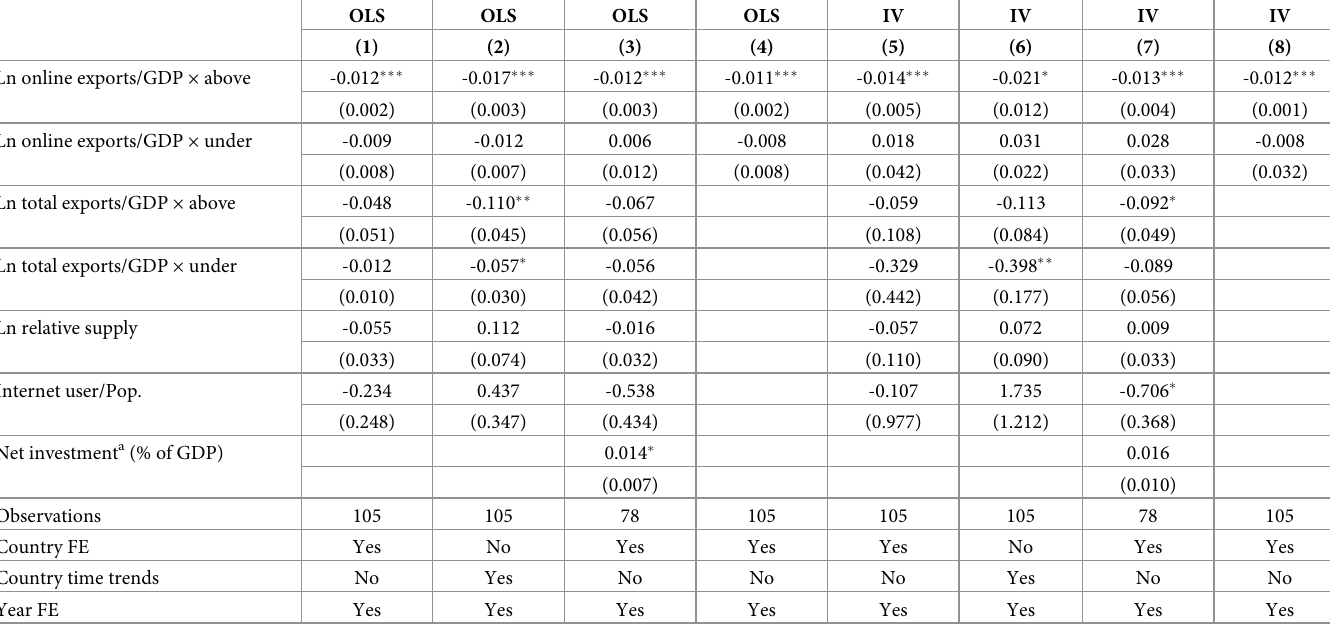
Table 9. Impact of online exports on the wage gap: The role of small